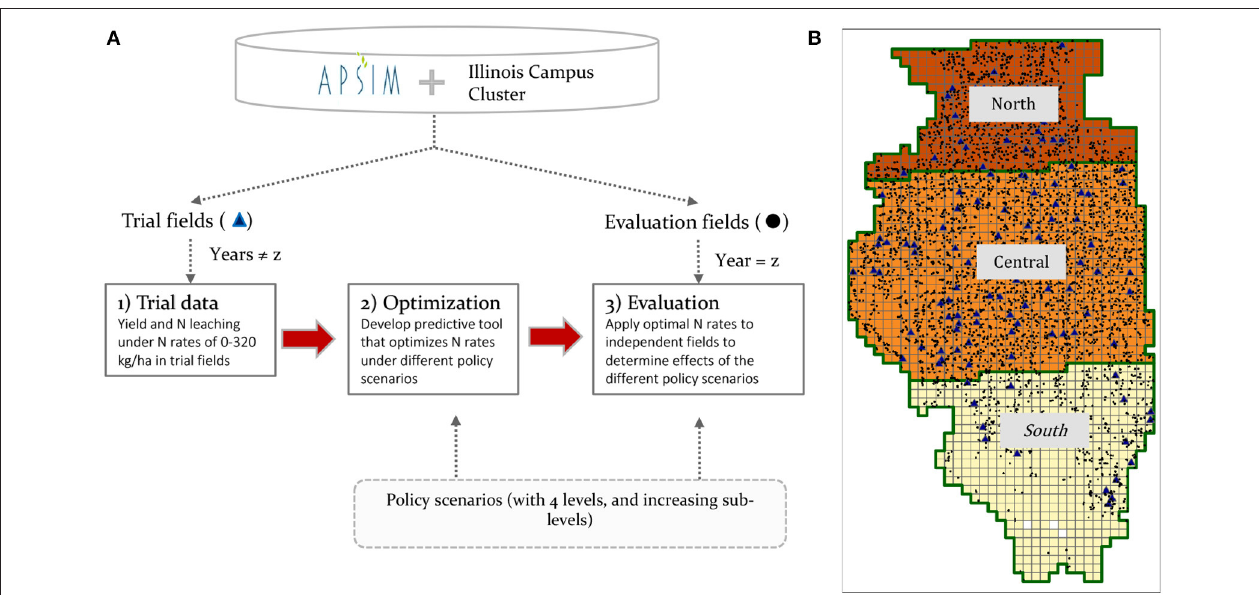
FIGURE 1 | (A) Schematic diagram of the flow chart followed in the analysis. Boxes indicate the major processes. Arrows indicate the flow of information. (B) Map of Illinois, showing the grid of 10 x 10 km cells, the three regions, the trial fields (triangles), and the evaluation fields